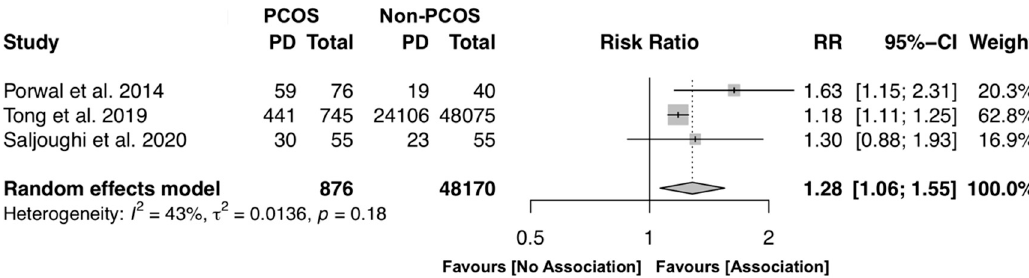
Figure 2. Forest plot of risk ratio of polycystic ovary syndrome (PCOS) female individuals to have periodontitis (PD) (p-value < 0.0001). Mean effect size estimates have been calculated with 95% confidence intervals and are shown in the figure. The size of the squares is proportionate to the study sample size, continuous horizontal lines and diamonds width represents 95% confidence interval. Diamond and the vertical dotted line represent the overall pooled estimate.